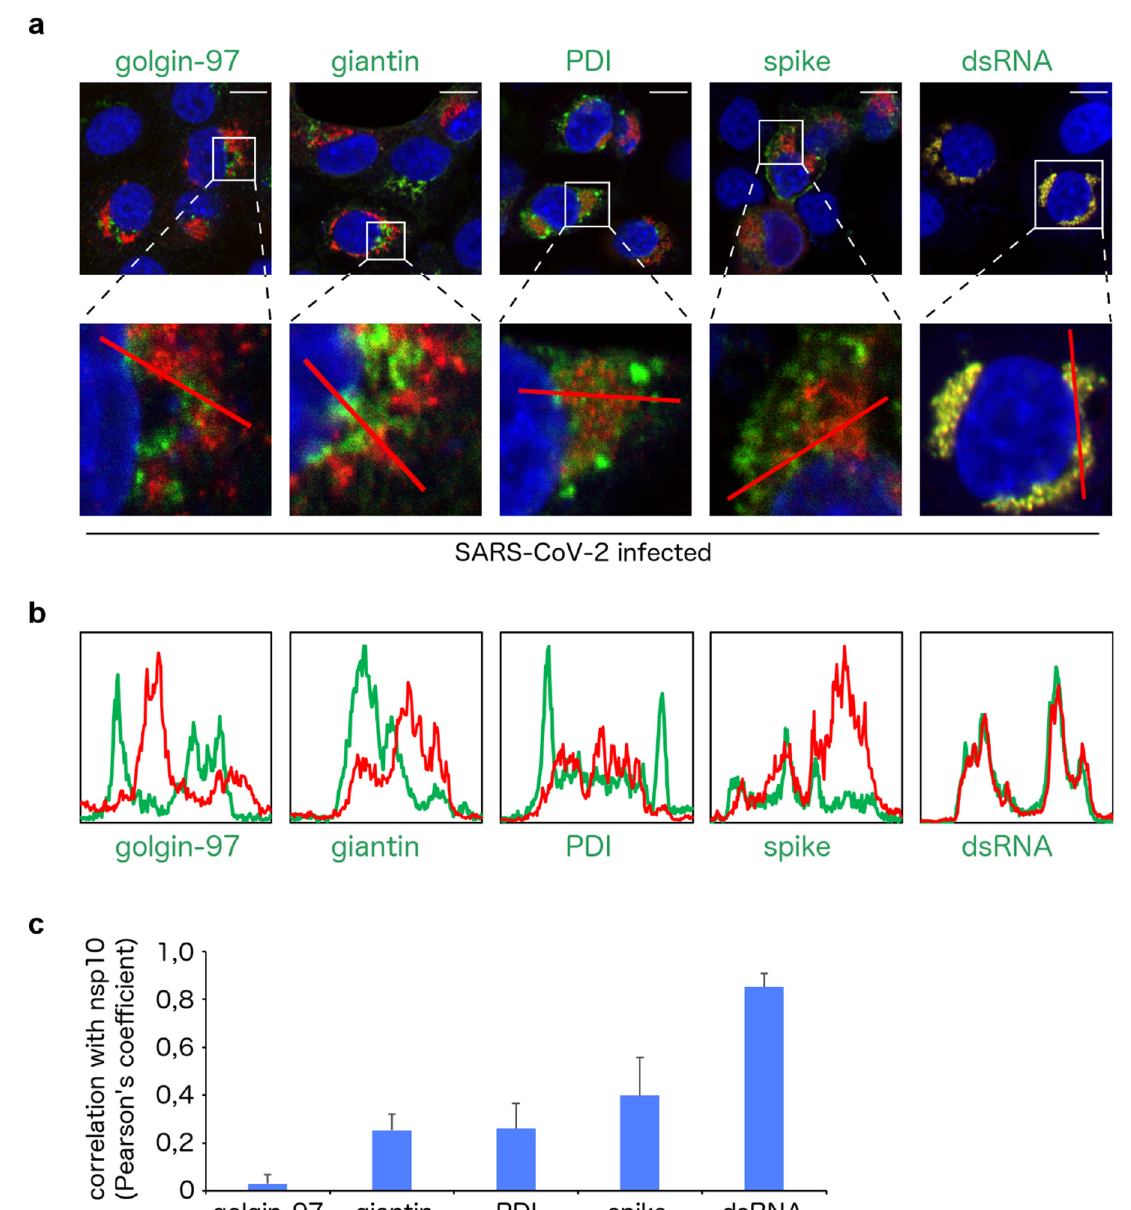
Figure 4. Analysis of the nsp10 subcellular localization in the SARS-CoV-2-infected cells. ( a ) A detailed view of the subcellular localization of the nsp10 protein (red) and its co-localization with several markers (green) as in Figure 3. Scale bars in the upper panel represent 10 µm. ( b ) Co-localization of the nsp10 protein (red) with several markers (green) is presented as the fluorescent intensity profile plots. The plots were generated using the selections indicated by the red lines in the magnified images in the bottom panel of Figure 4a. ( c ) Statistical analysis of the co-localization of the nsp10 protein with several markers is presented as Pearson correlation coefficients ± standard deviations from at least 10 cells.